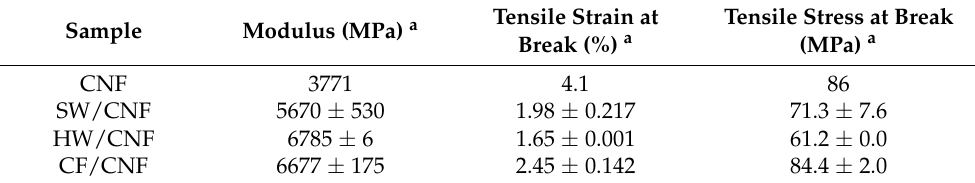
Figure 7. Stress–strain curves for the fabricated lignocellulose membranes. Table 1. Mechanical properties of the fabricated films.